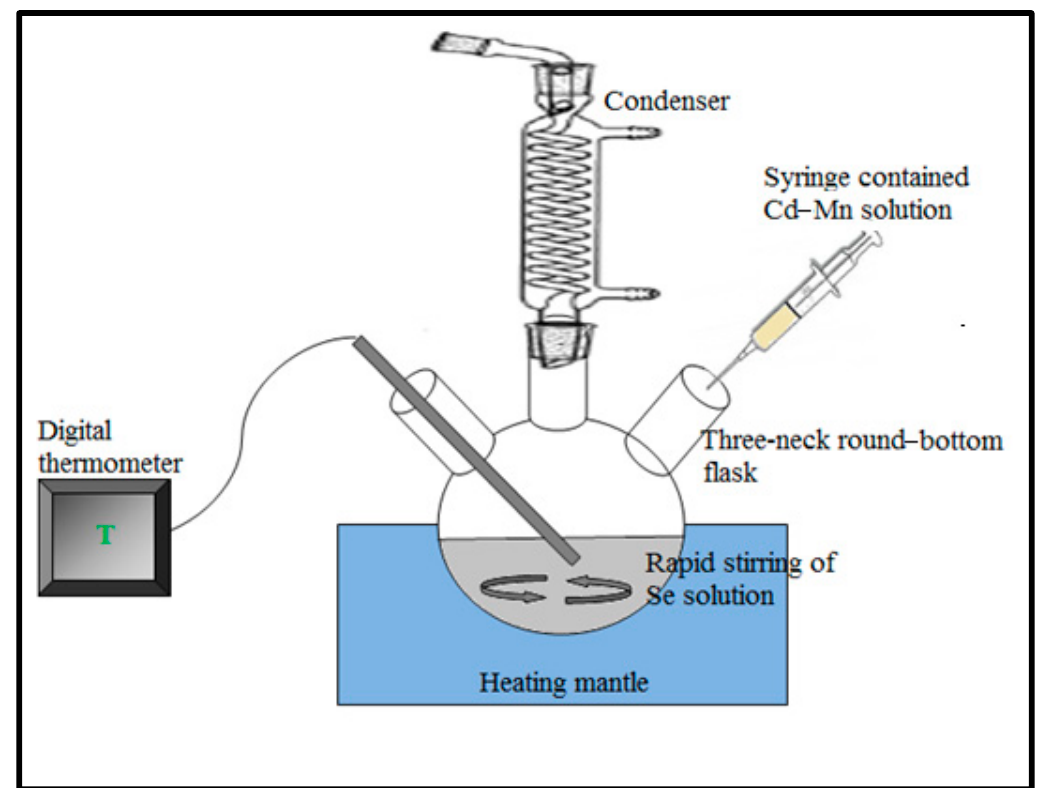
Figure 1. The experimental setup for the Mn-doped CdSe QD (quantum dot) sample.